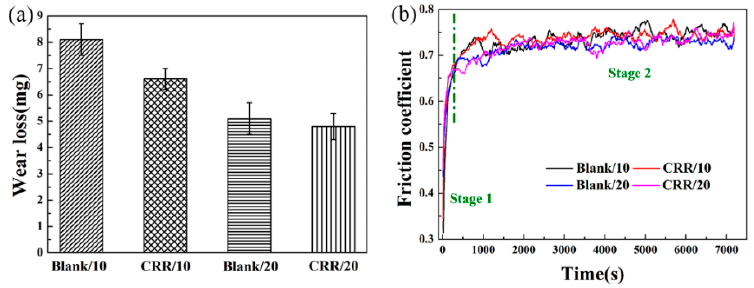
Figure 5. Wear loss ( a ) and friction coefficient ( b ).